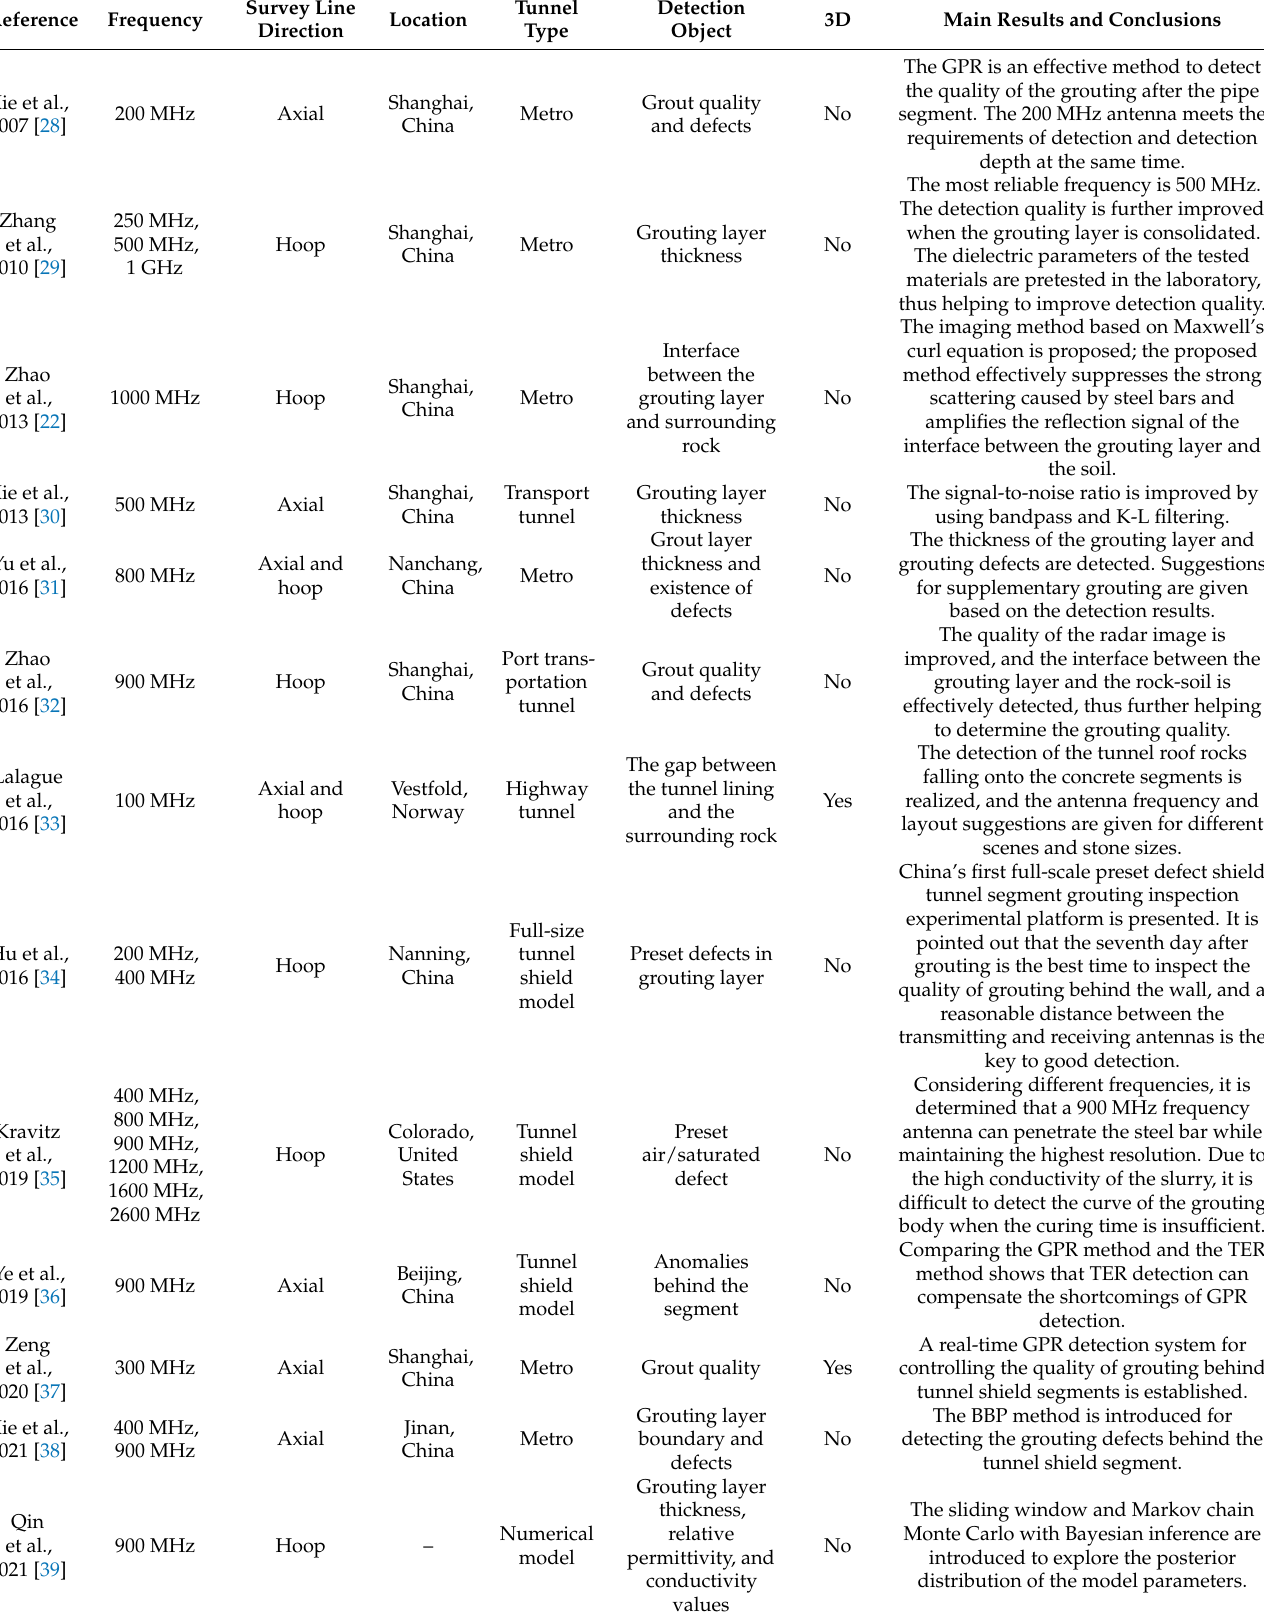
Table 1. Some examples of GPR applications on tunnel liners and